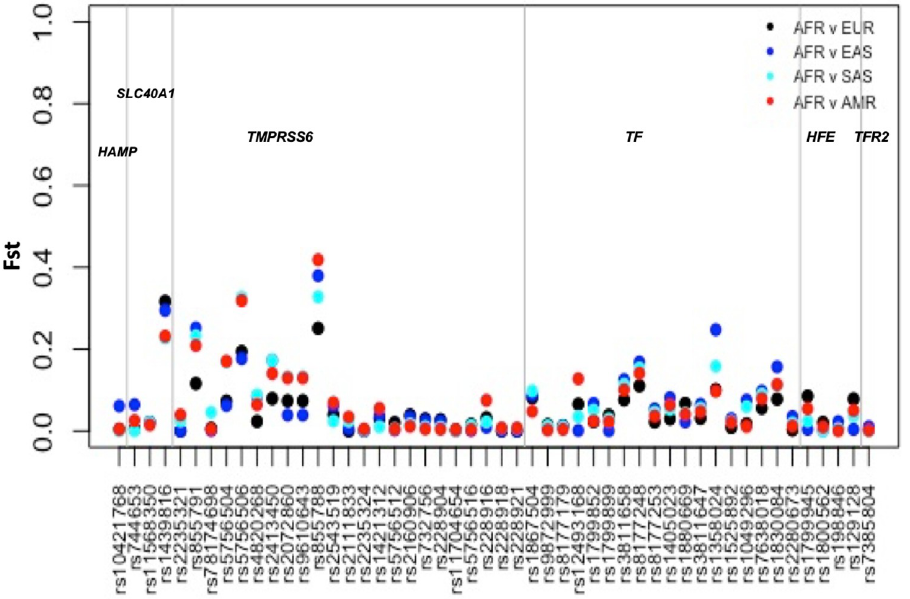
Fig 9. Pairwise F ST values for iron related SNPs between African and non-African populations. This figure scores between African and other global populations. AFR, African; AMR, American; illustrates the comparison of F ST EUR, European; EAS, East Asian; SAS, South Asian, F ST , fixation index.